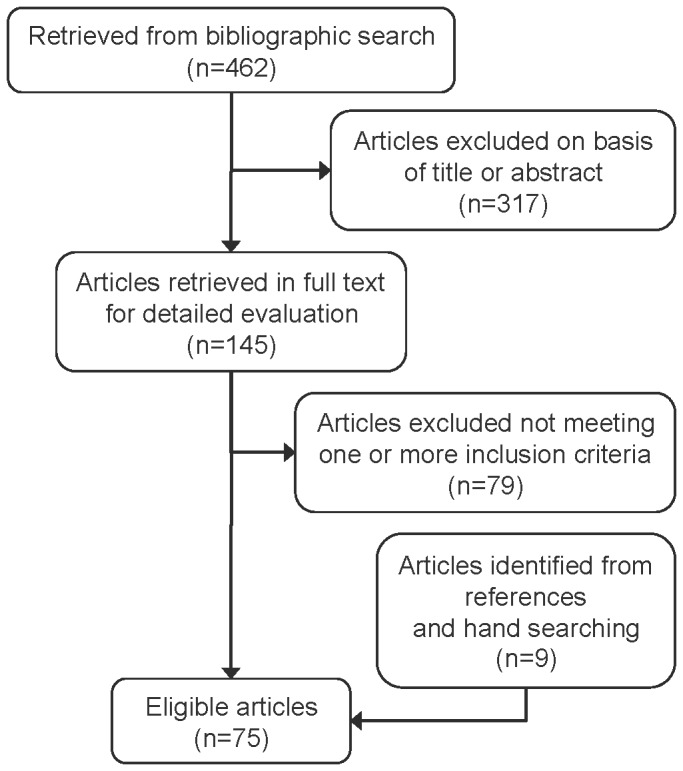
Flow diagram of study selection
process.